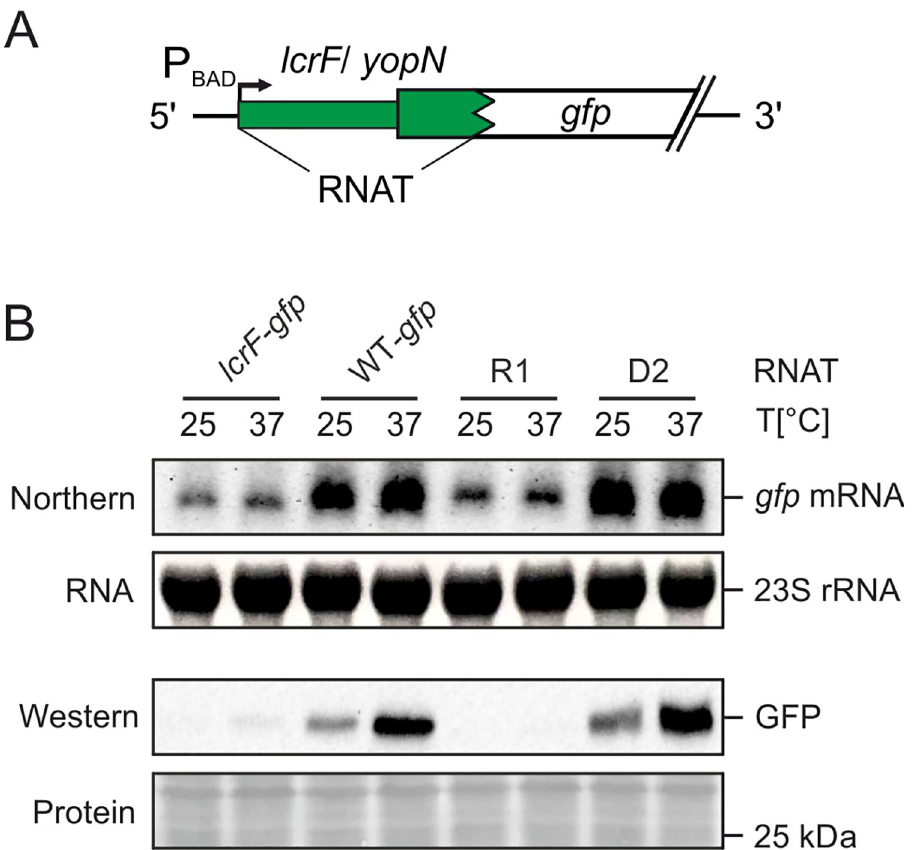
Fig 4. Temperature-controlled expression of gfp by the short yopN RNAT. (A) Plasmid-based translational fusions of yopN : gfp were cloned to test RNAT functionality at RNA and protein levels. Transcription of the fusion product is controlled by the arabinose inducible promotor P BAD . (B) Determination of transcript and protein levels of yopN : gfp (WT- gfp ) and mutated yopN variants (R1 and D1) by Northern and Western blot analyses, respectively. The RNAT of lcrF served as a positive control [8]. Y . pseudotuberculosis YPIII cells carrying plasmids of the fusion constructs were grown to an OD 600 of 0.5 at 25˚C. Transcription was induced by 0.1% (w/v) L-arabinose and the cultures were split to flasks at 25˚C and prewarmed flasks at 37˚C and incubated for further 30 minutes. Samples were then taken for Northern and Western blot analyses. The blots shown represent one of three biological replicates. To ensure equal amounts of RNA, a total of 10 μ g of RNA was loaded per sample. Ethidium bromide stained 23S rRNA served as loading control. Protein amounts were adjusted to an optical density of 0.5 and detected by Ponceau S staining after blotting onto a nitrocellulose